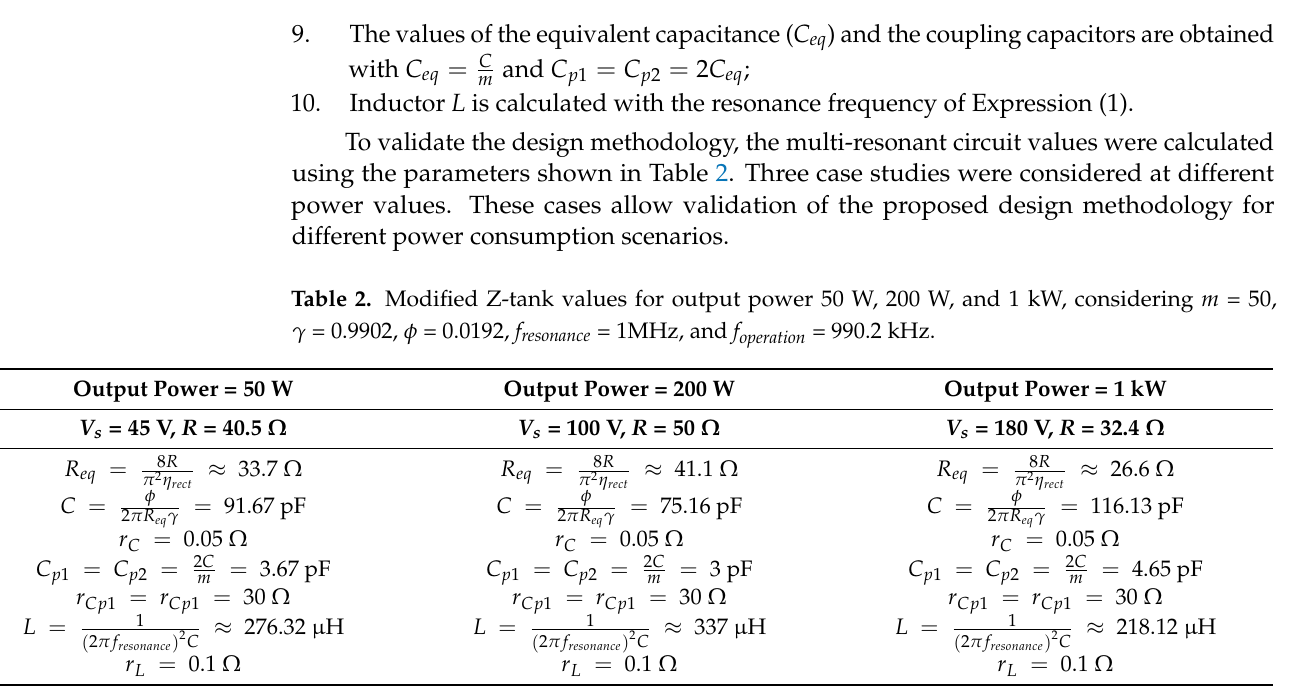
Table 2. Modified Z-tank values for output power 50 W, 200 W, and 1 kW, considering m = 50, γ = 0.9902, 𝜙 = 0.0192, f resonance = 1MHz, and f operation = 990.2kHz.